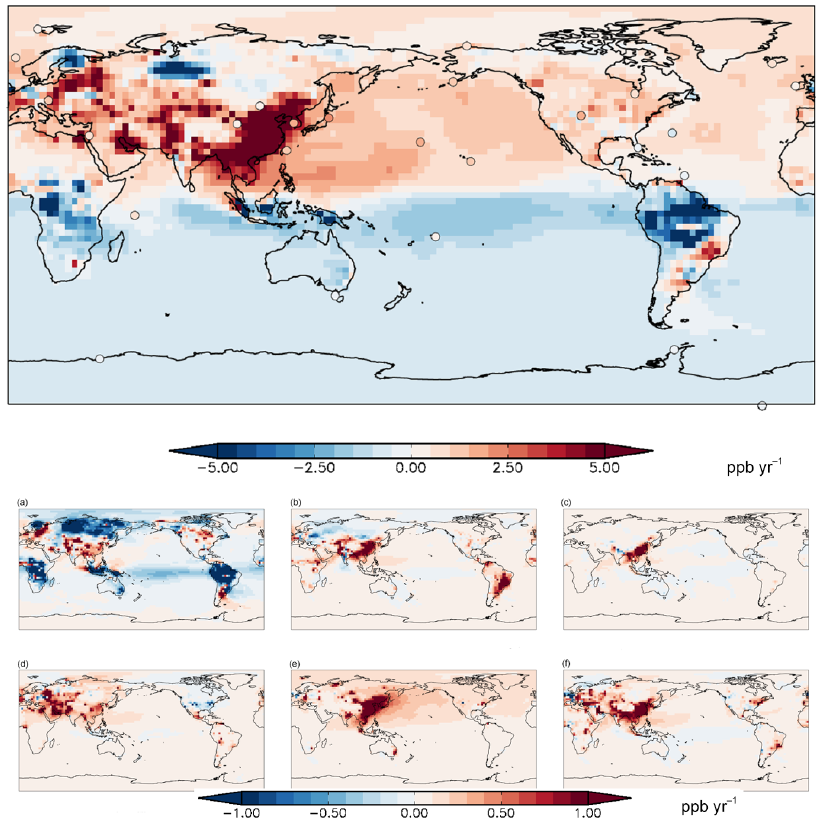
Figure 13. (Upper panel) Mean year-to-year growth (ppbyr − 1 ) in surface CH 4 in Oslo CTM3 over the period 2001–2006. The 25 circles show the observed growth rates over the same period. The stations picked for comparison is based on the criteria described in Sect. 2.3, and only observation sites that have measurements available for all months within the given time is included. (a – f) Mean year-to-year growth (ppbyr − 1 ) of emission tracers in the same period. (a) Natural (wetlands + other natural + biomass burning), (b) enteric, (c) agricultural soils, (d) gas, (e) solid fuel, (f) the sum of all other anthropogenic